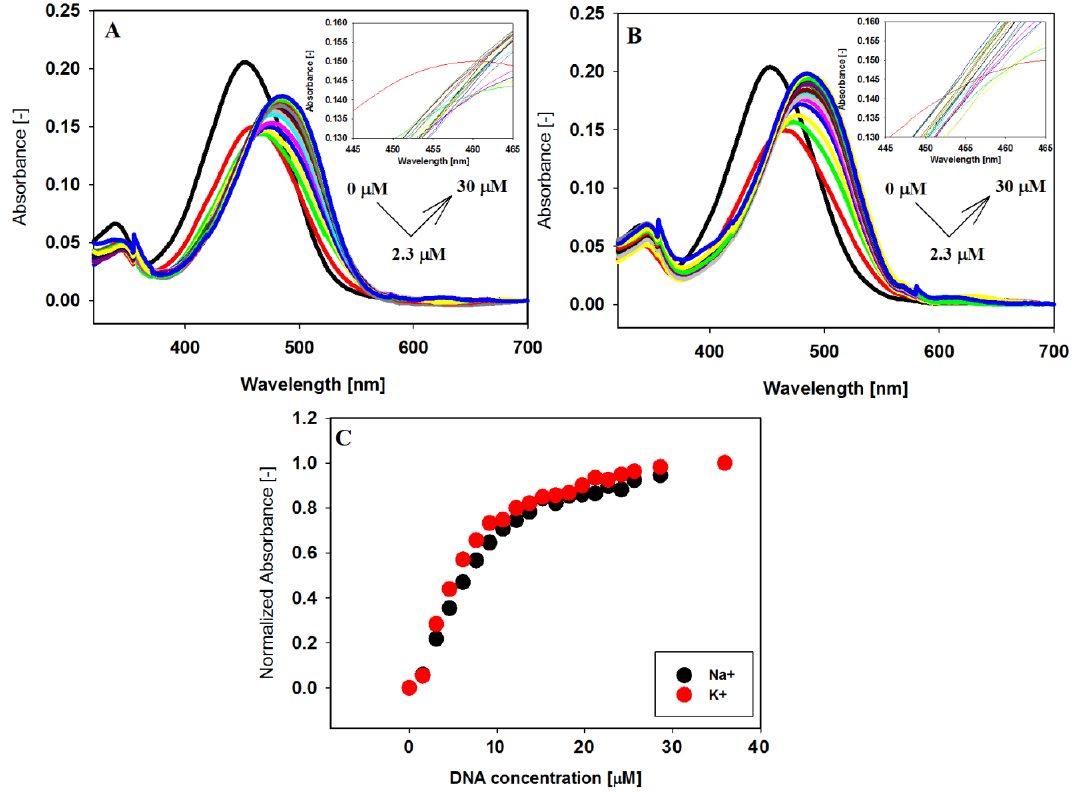
Figure 3. Spectrophotometric titration of ligand 3 (6 µM) with 22HT G4 (0–36 µM) in Tris-HCl buffer (10 mM, pH 7.2) containing 100 mM NaCl ( A ) and 100 mM KCl ( B ). Panel ( C ) shows normalized absorbance changes vs. increasing concentration of 22HT G-quadruplex at 499 nm (Na + ) and 492 nm (K + ).